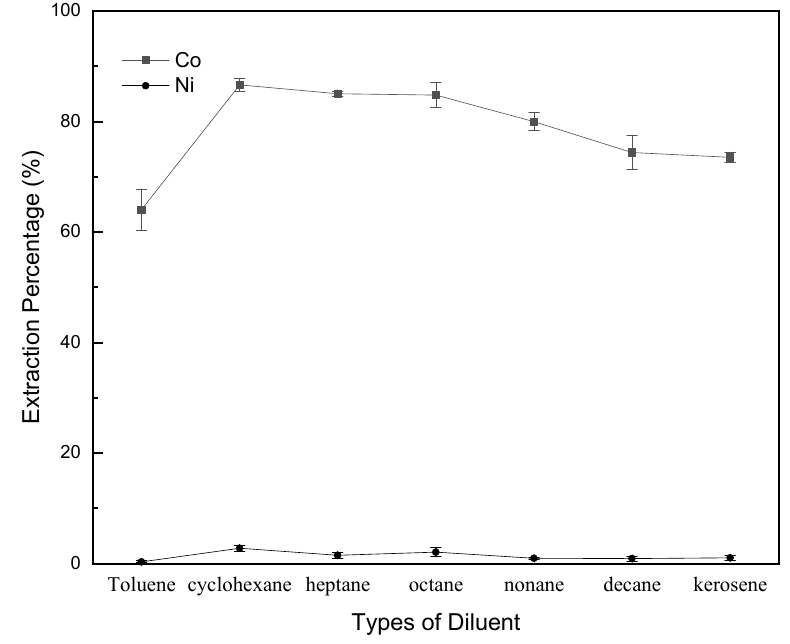
Figure 9. Effectiveness of different diluents for extraction percentages of cobalt and nickel. P- Figure 9. E ff ectiveness of di ff erent diluents for extraction percentages of cobalt and nickel. 507/diluent—1:4 v/v ; saponification: 60%; complexing reagent—ammonium thiocyanate; O/A—1:1). P-507 / diluent—1:4 v / v ; saponification: 60%; complexing reagent—ammonium thiocyanate; O /